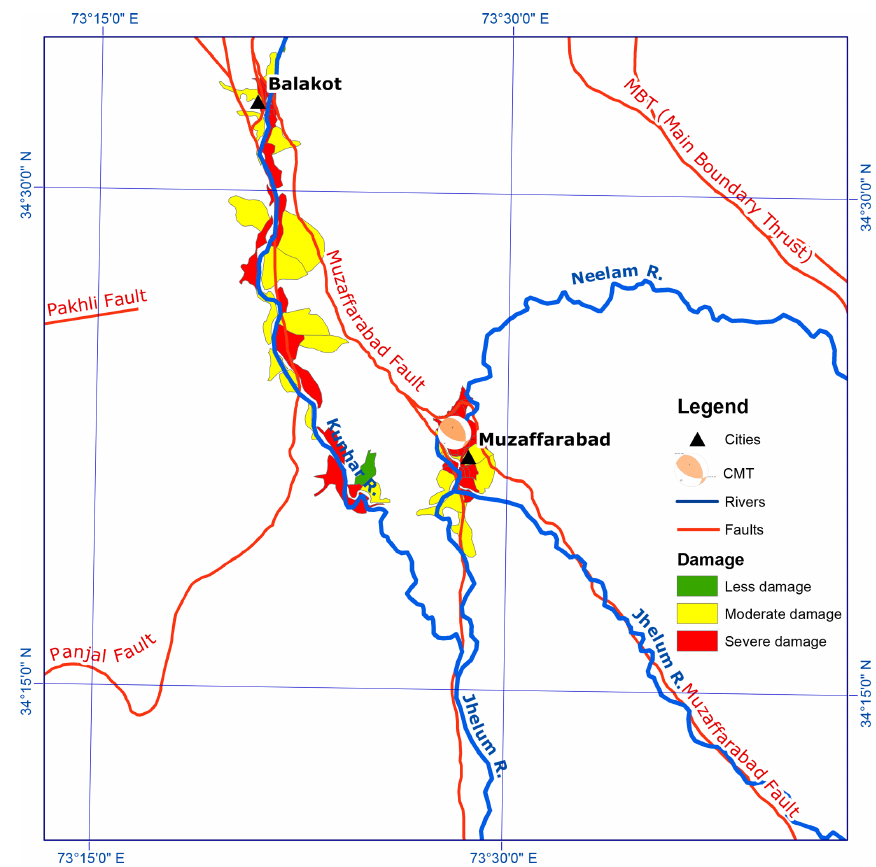
Figure 2. Data on damage induced by the 2005 Kashmir earthquake after Shafique et al.